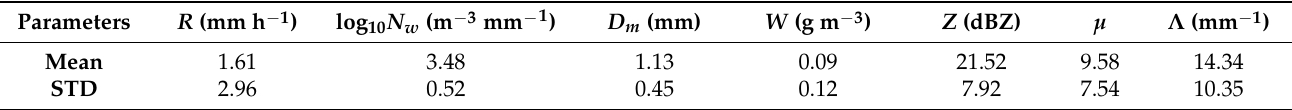
Table 1. Several important rainfall parameters for all samples.